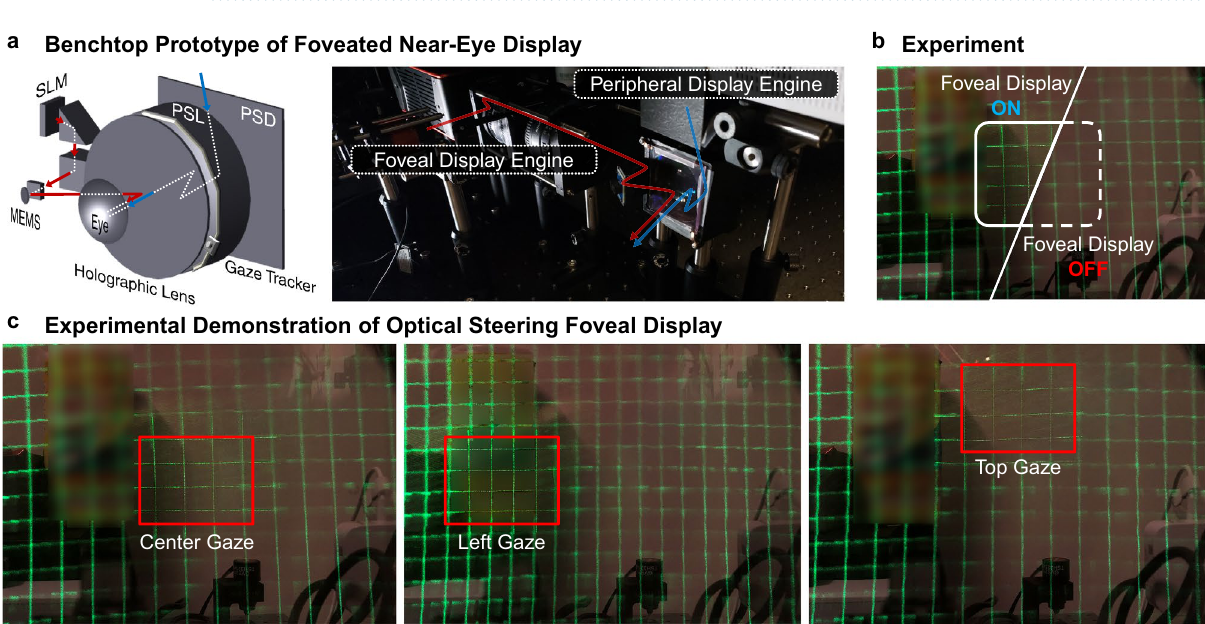
Figure 3. The optical principle of the steering range extension using a S-PBP module. The proposed method is verified by Zemax simulation. In-house fabricated S-PBP’s photograph is also presented on the right-hand side. Note that the rainbow in the photograph is the grating effect of the PBP grating.